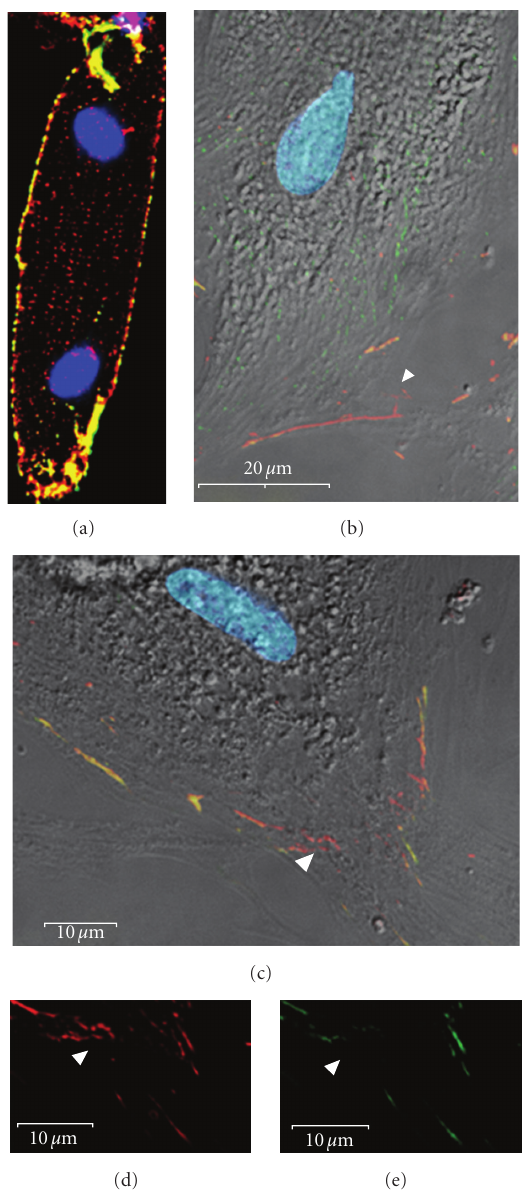
Figure 2: Early remodeling of the intercalated disks of isolated adult rat ventricular cardiomyocytes in primary culture. (a) One day post plating, PKP2 (green) and N-cadherin (red) relocalize from the intercalated disks to the lateral sarcolemma. (b)–(e) By day 3 post plating, very immature cell-cell contacts have begun to form between the spreading cardiomyocytes. N-cadherin (red) specifically localizes to these contact sites before PKP2 (green). Note that these new cell contacts predominantly contain either N- cadherin (arrowheads in (b)–(f)) or both N-cadherin and PKP2 ((b)–(f): yellow) but not PKP2 alone. Scale bars are 20 μ m (b) and 10 μ m